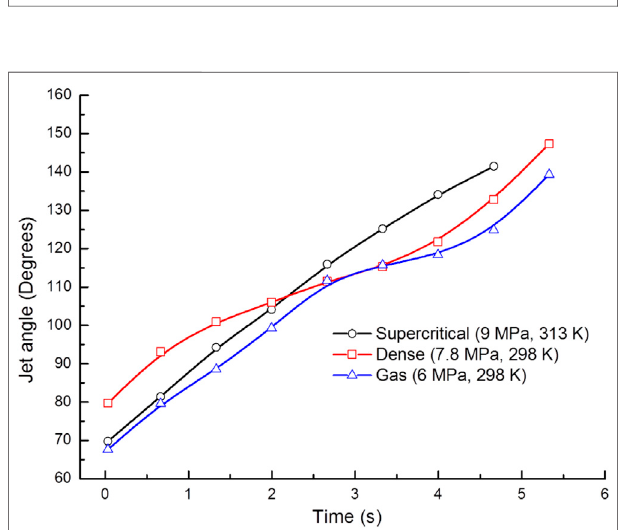
FIGURE 8 | The effect of phase states on the jet angle (5x1 mm).